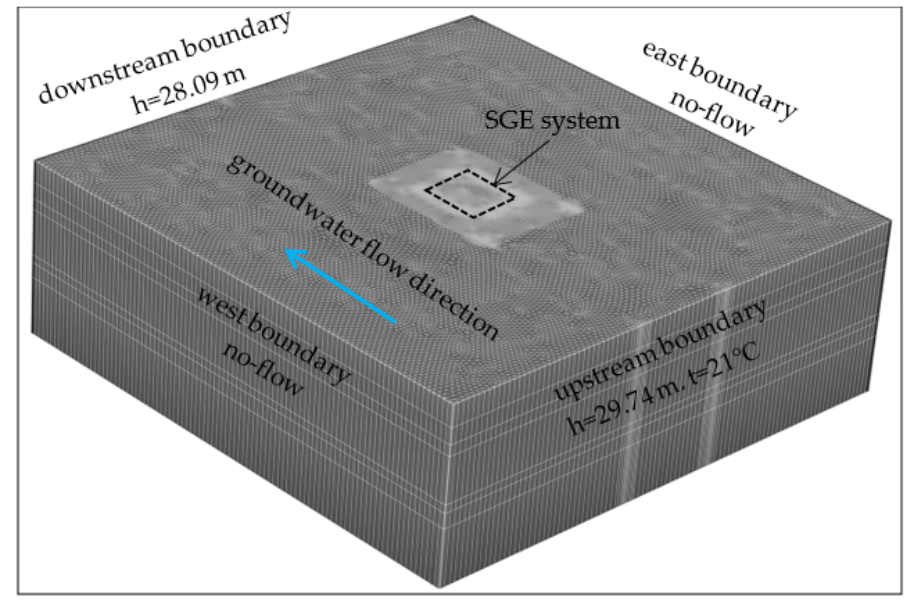
Figure 3. The geometric model of the model.